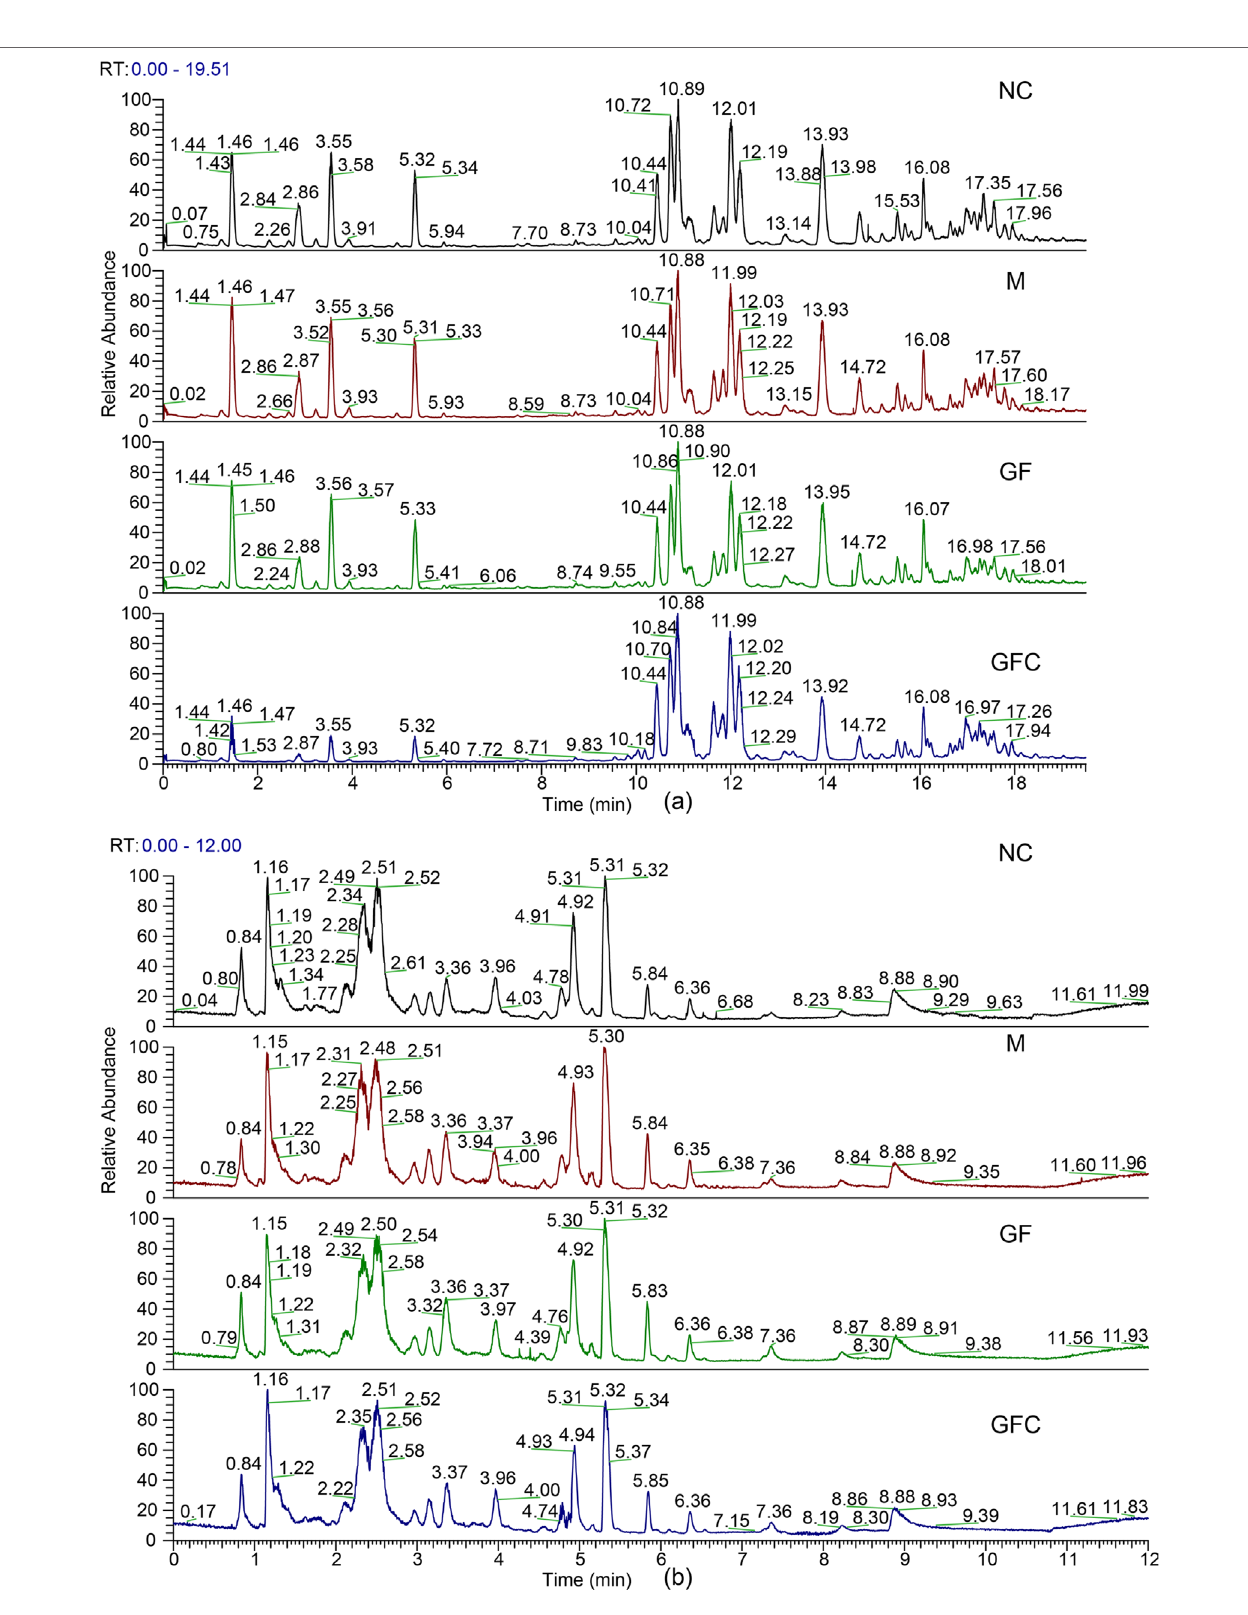
FIGURE 2 | Total ion chromatograms of the normal control (NC), model (M), GF, and GFC groups in the C18/UHPLC/MS (A) and HILIC/UHPLC/MS (B) system with positive